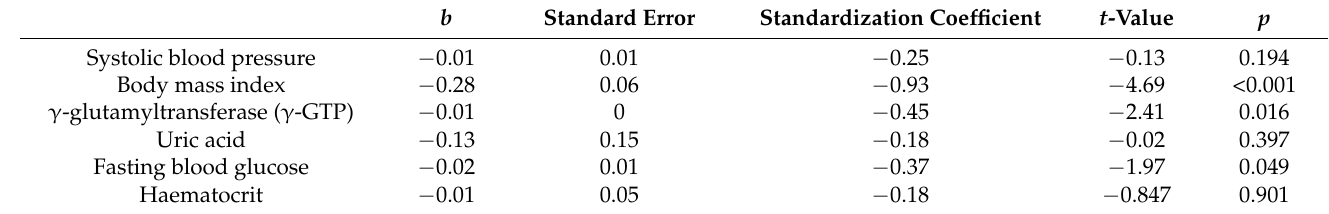
Table 3. Multiple regression analysis for predicting grey matter brain healthcare quotient.